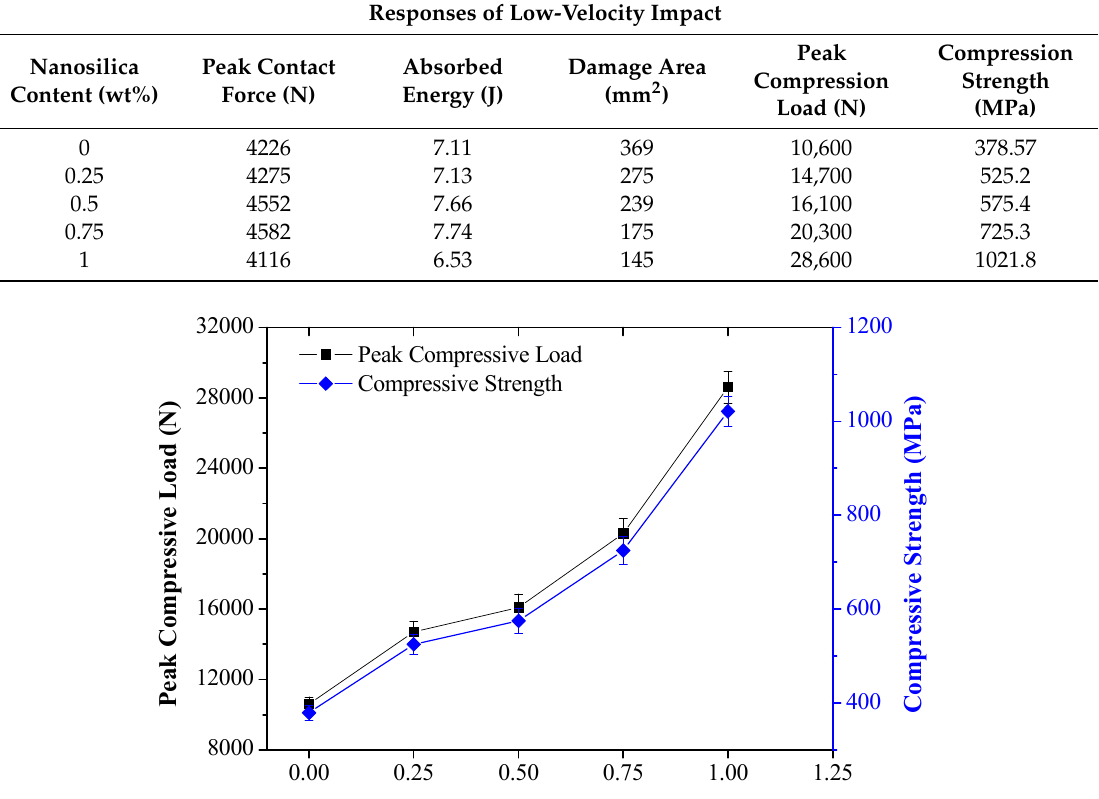
Table 1. Responses of low-velocity impact.